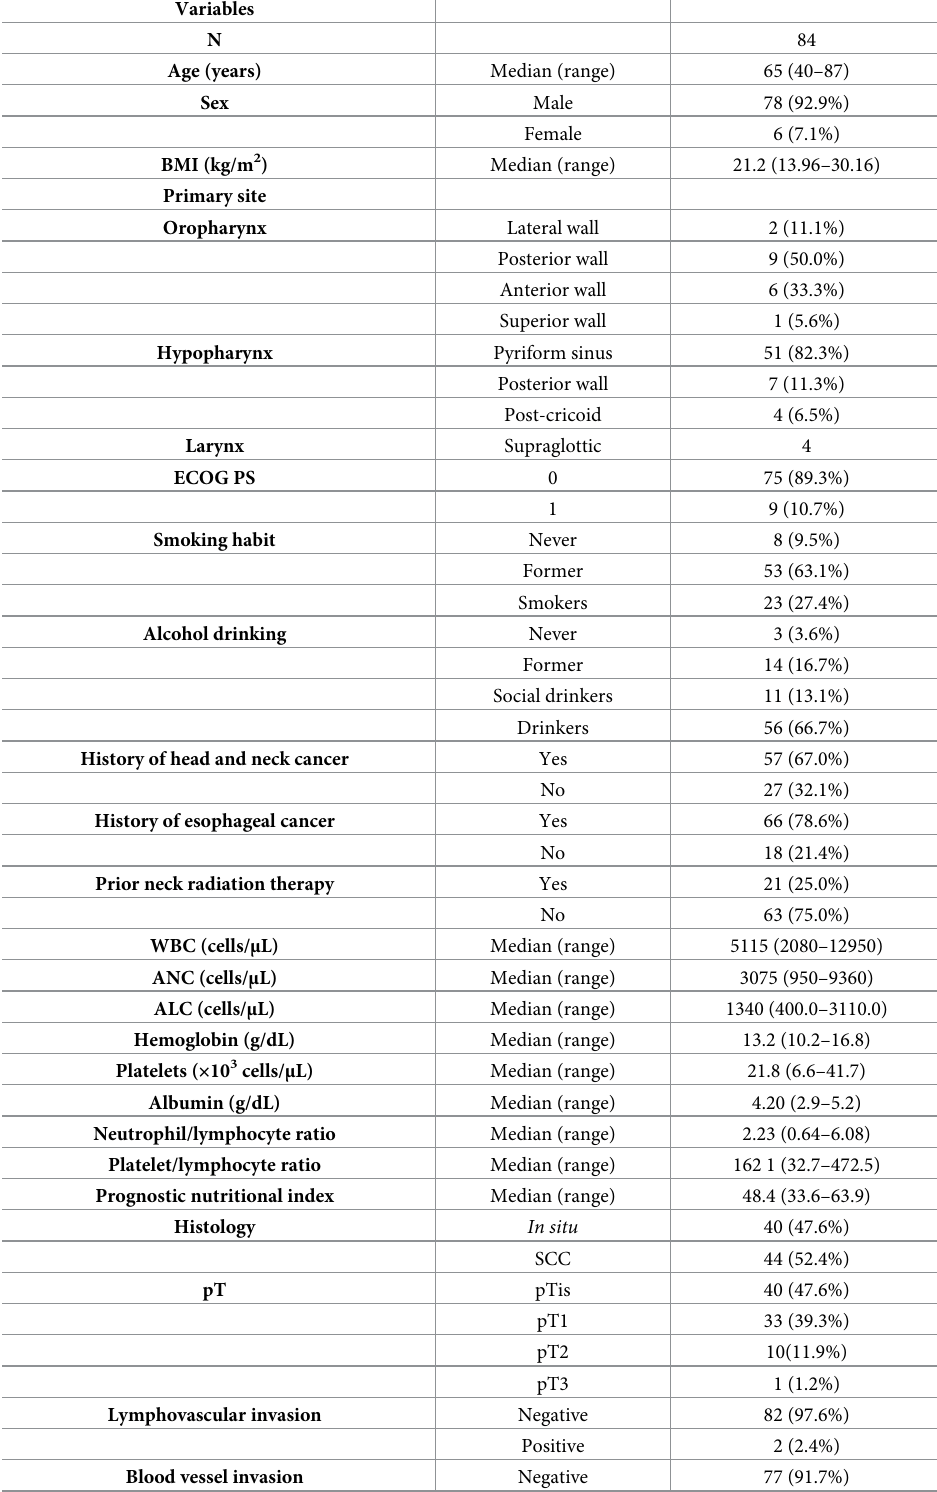
Table 1. Clinicopathological